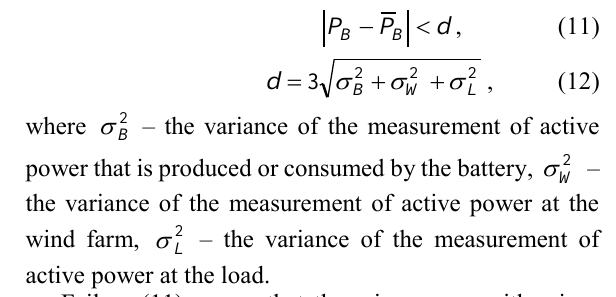
Fig.3 . Wind speed